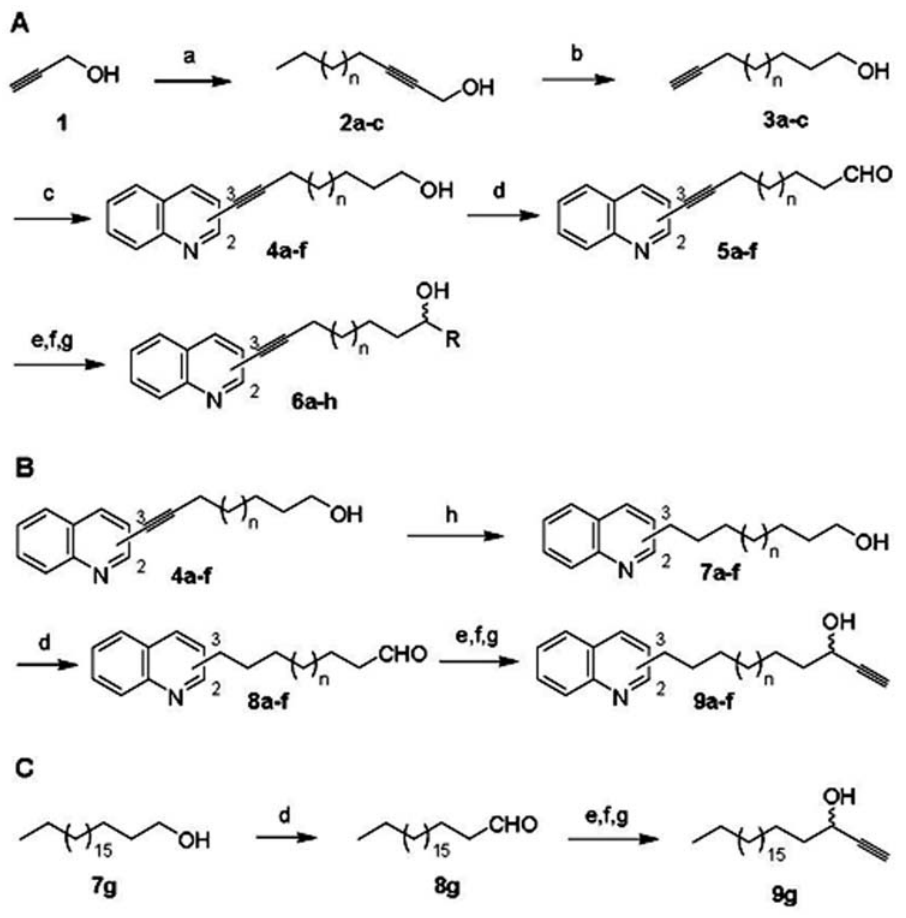
Figure 1. Syntheses of quinoline-derived compounds. Reagents and conditions were as follows. (A) (a) Fe(NO 3 ) 2 .9H 2 O (cat), Li (3 equiv), NH 3 , 2 40 u C to rt, 6 h; (b) NaH (6.3 equiv), NH 2 (CH 2 ) 3 NH 2 , 70 u C, overnight ( 4a ) bromooctane (1 equiv) ( 4b ) bromodecane (1 equiv) ( 4c ) bromododecane (1 equiv); (c) PdCl 2 (PPh 3 ) 2 (0.05 equiv), CuI (0.1 equiv), Et 3 N (5 equiv), THF, reflux, 3 h. ( 4a–c ) 2-chloroquinoline (1 equiv) ( 4d–f ) 3-bromoquinoline (1 equiv); (d) (i) DMSO (5.8 equiv), (ClCO) 2 (2.2 equiv), CH 2 Cl 2 , 2 50 u C, 15 min then 2 h. (ii) Et 3 N (10 equiv), 2 50 u C to rt; (e) (i) HC ; C-TMS (1 equiv), n -BuLi (1.2 equiv), 2 78 u C, 1 h (ii) TBAF (1.06 equiv), THF, rt, 10 min. (f) BrMg- CH=CH 2 (1.2 equiv), THF, 2 78 u C, 2 h. (g) BrMg-cyclopropyl (1.2 equiv), THF, 2 78 u C, 2 h. (B) (h) H 2 , Pd/C (20% w:w), EtOH abs , rt, overnight.